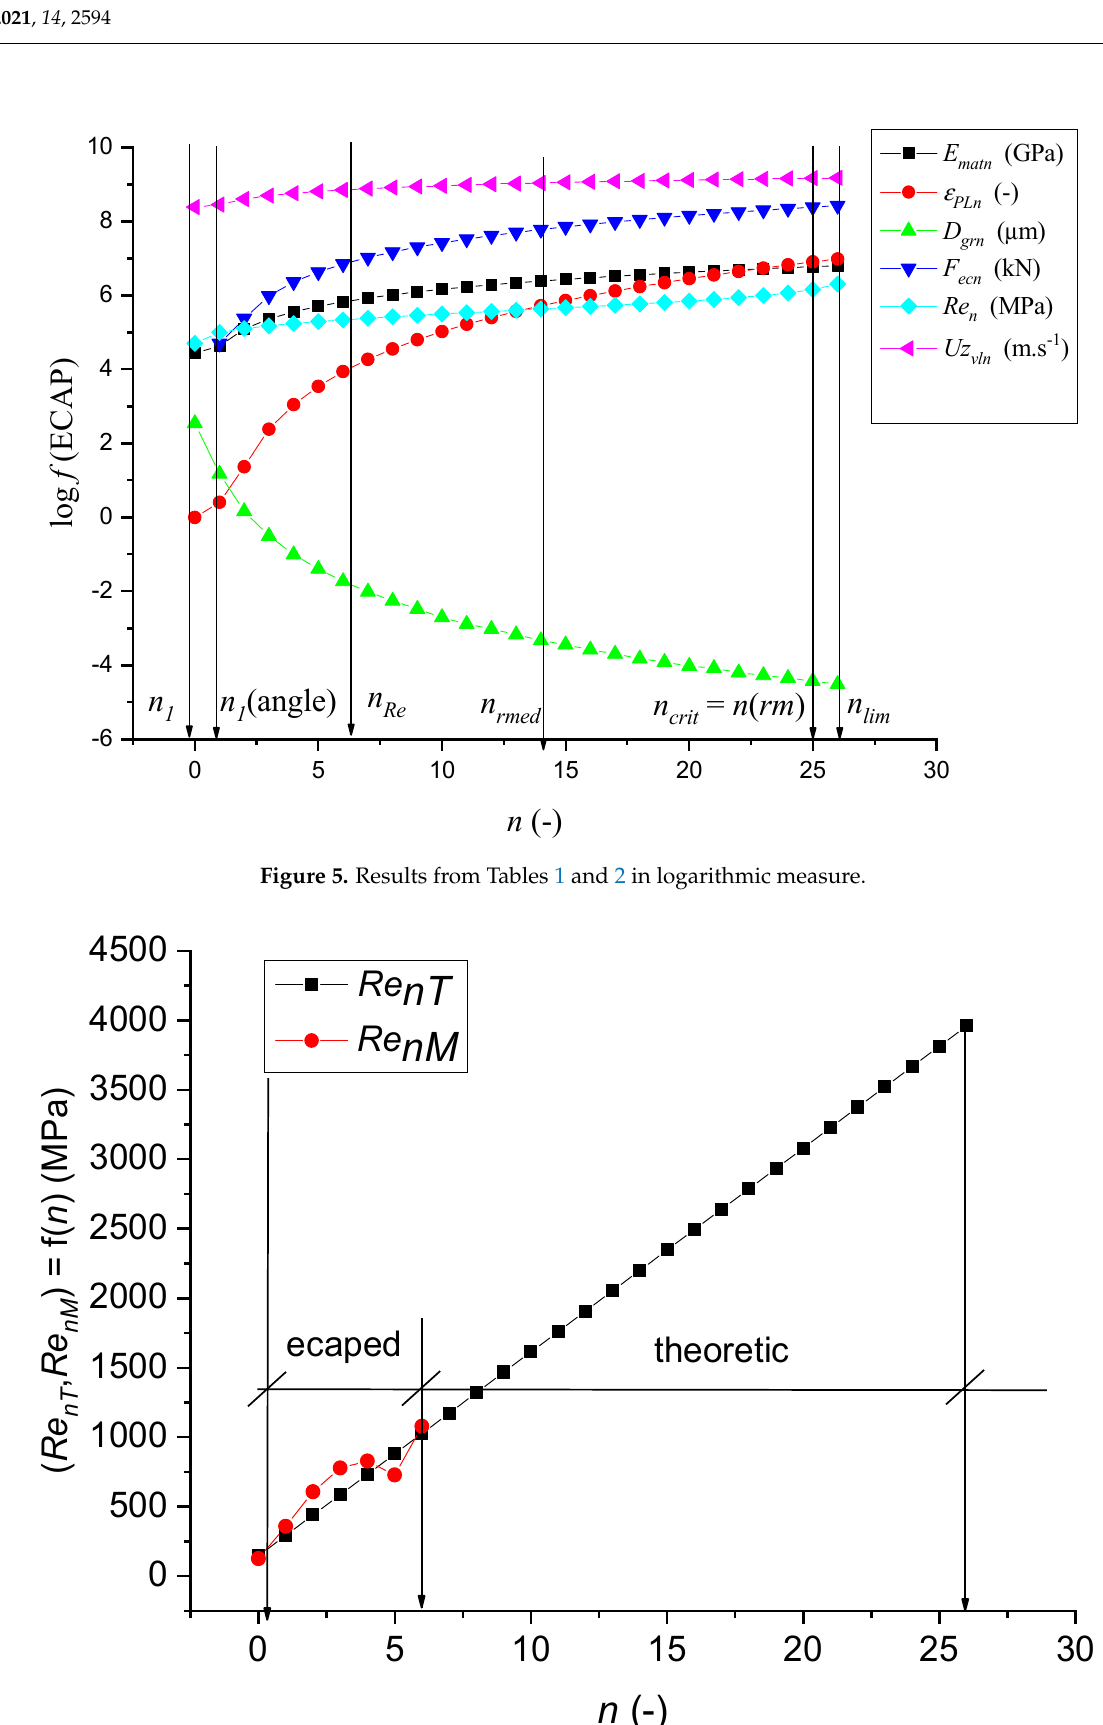
Figure 4. Dependence of ultrasonic speed UZ vlnM on the number of extrusions n .